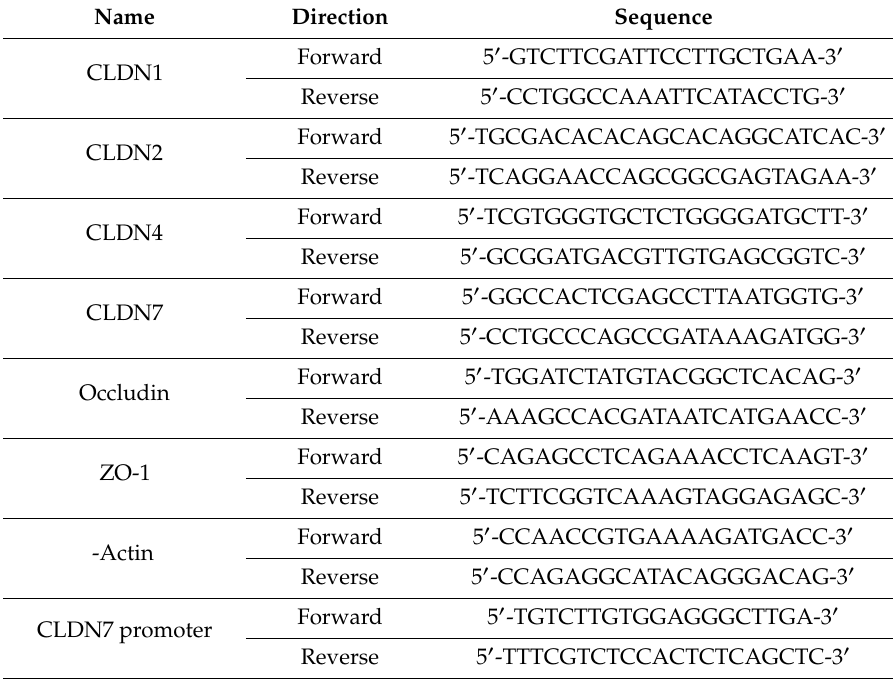
Table 1. Primer pairs for